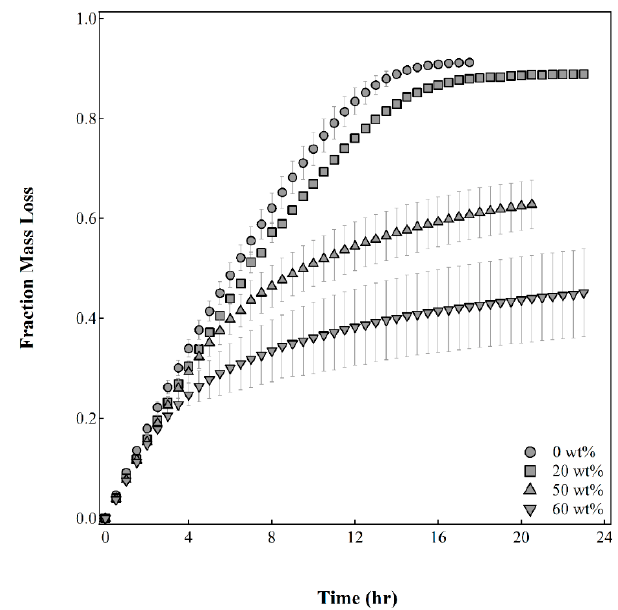
Figure 4. Fraction mass loss as a function of time for capsules made from emulsions with varying initial compositions of silicone oil. Error bars represent standard deviation, n = 10.